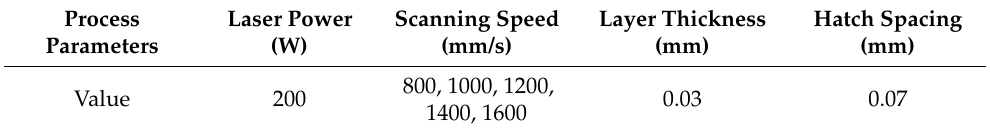
Table 1. Laser powder bed fusion process